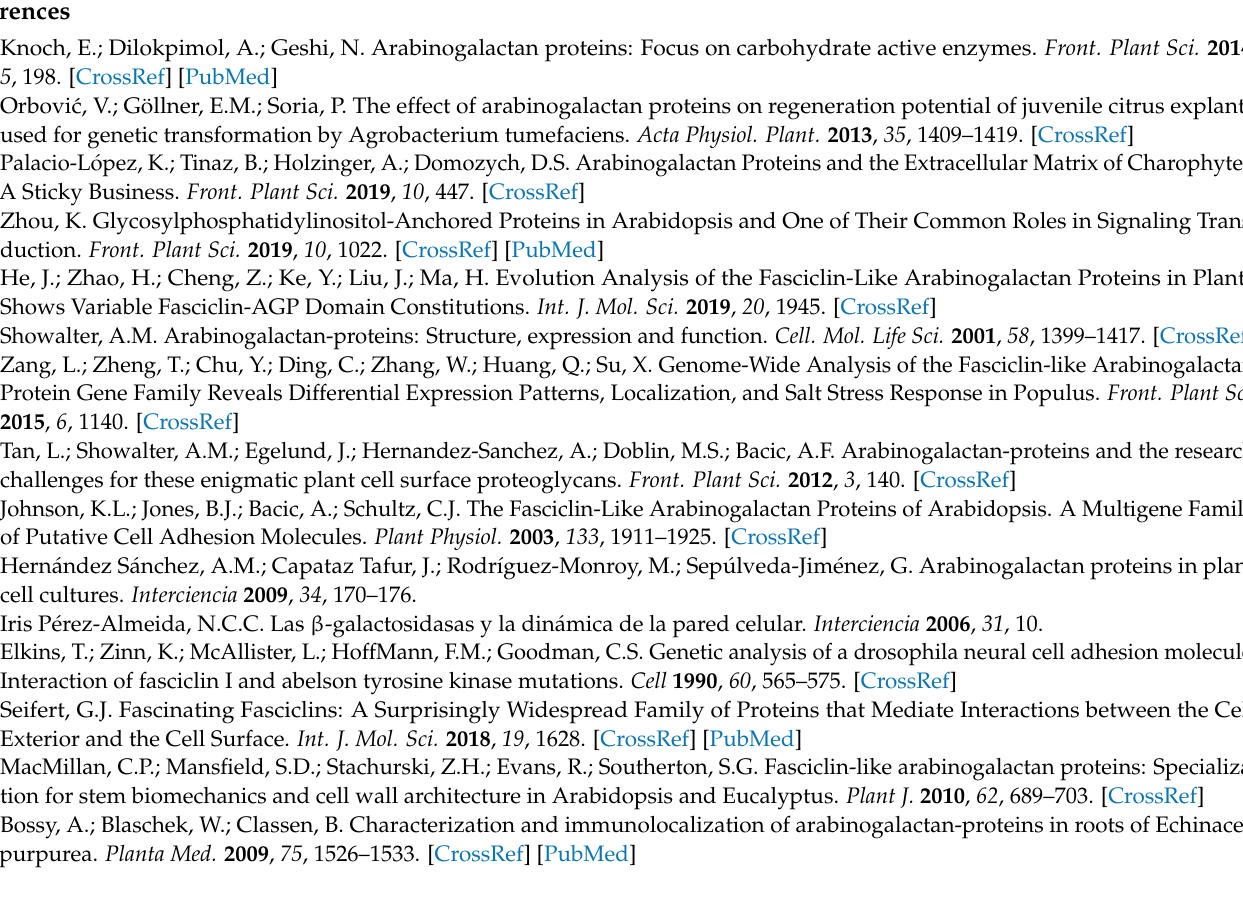
regions and motifs, H1 (blue square), YH (green square) and H2 (yellow square); Supplementary Figure S3. Alignment of radiata pine versus Arabidopsis thaliana sequences, group C according to phylogeny. Highlighting whether there is the presence of 1 or 2 FAS domains (mustard-colored line) and whether the elements of this domain contain their characteristic regions and motifs, H1 (blue square), YH (green square) and H2 (yellow square); Supplementary Figure S4. Alignment of radiata pine versus Arabidopsis thaliana sequences, group D according to phylogeny. Highlighting whether there is the presence of 1 or 2 FAS domains (mustard-colored line) and whether the elements of this domain contain their characteristic regions and motifs, H1 (blue square), YH (green square) and H2 (yellow square); Supplementary Figure S5. Measurement of area of staining in samples treated with Antibody. (A) Staining area treated with JIM7 antibody, in control stem samples, inclined at 2.5 h upper and lower cuts, 10 h upper and lower cuts, 24 h upper and lower cuts. (B) Staining area treated with LM2 antibody, in control stem samples, inclined at 2.5 h upper and lower cuts, 10 h upper and lower cuts, 24 h upper and lower cuts. (C) Staining area treated with LM6 antibody, in control stem samples, inclined at 2.5 h upper and lower cuts, 10 h upper and lower cuts, 24 h upper and lower cuts. The letters indicated significance differences, and * p < 0.05, ** p < 0.01, *** p < 0,001; Table S1. Putative FLAs identified in